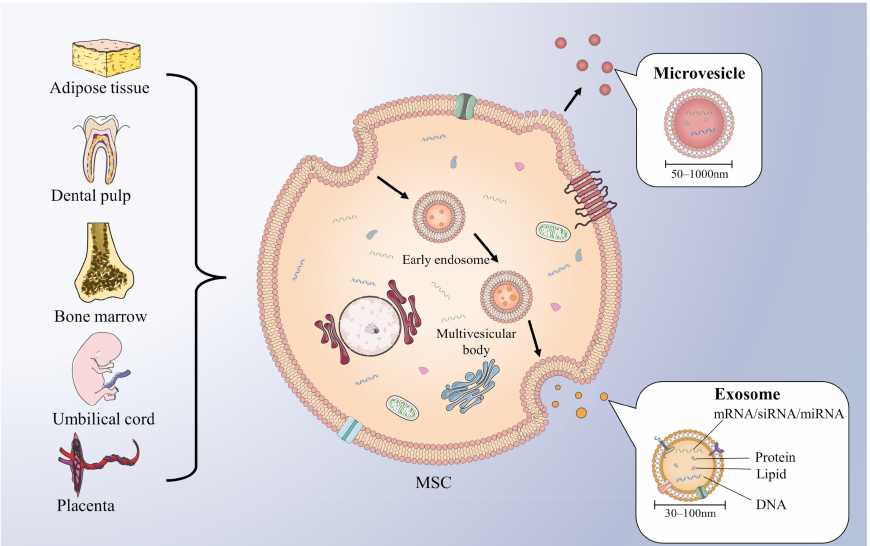
Figure 1. Various sources of MSCs and the generation of EVs. MSCs are mainly originated from adipose tissue, dental pulp, bone marrow, umbilical cord, and placenta. Inward budding formed early endosomes matured to form multivesicular bodies, which fuse with plasma membrane release exosomes. Exosomes (30–150 nm) are EVs contains miRNA, protein, lipid, and DNA. Microvesicles (50–1000 nm) are EVs released directly from the plasma